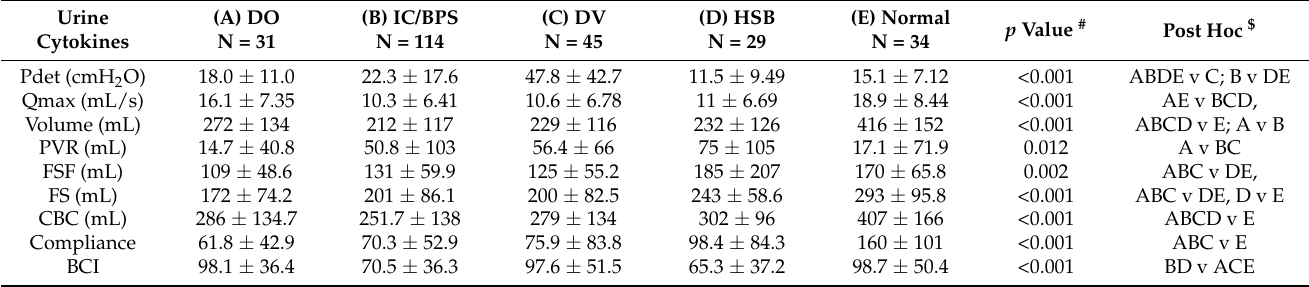
Table 1. Urodynamic parameters of women with bladder dysfunctions and normal tracing.